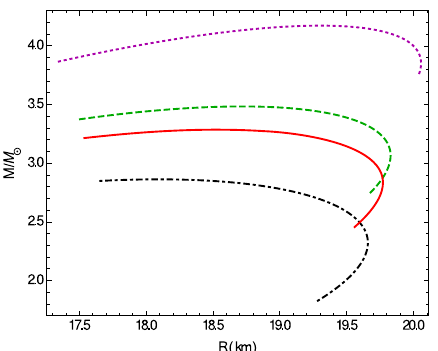
Fig. 3 Variation of M / M (cid:2) as a function of the radius of the star R (km) for three-form stiff-fluid stars, for three different values of the constant ¯ λ for three different values of the constant ¯ λ : ¯ λ = 0 (dashed curve), ¯ λ = 0 . 02 (dotted curve), and ¯ λ = − 0 . 02 (dot-dashed curve), respectively. The solid curve represents the mass–radius relation for general relativistic stiff-fluid stars Table 1 The maximum mass and corresponding radius for three-form field stiff-fluid stars with constant potential ¯ λ − 0 . 02 0 .